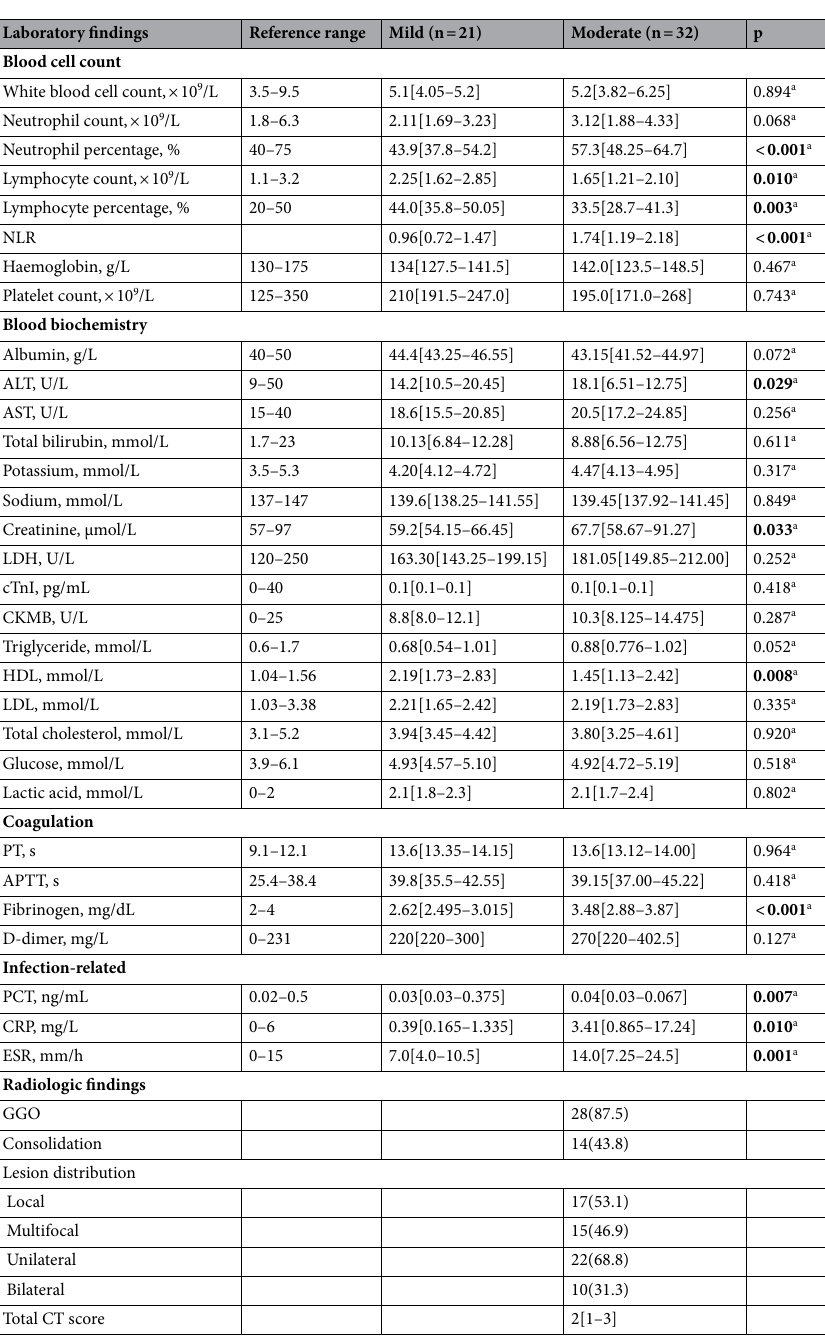
Table 2. Laboratory findings of patients with COVID-19. Laboratory findings are presented as the median (25% quantile-75% quantile); radiologic findings are presented as the number of cases (percentage). NLR neutrophil-to-lymphocyte ratio; ALT alanine aminotransferase; AST aspartate aminotransferase; LDH lactate dehydrogenase; cTnI cardiac troponin I; CKMB MB isoenzyme of creatine kinase; HDL high density lipoprotein; LDL low density lipoprotein; PT prothrombin time; APTT activated partial thromboplastin time; PCT procalcitonin; CRP C-reactive protein; ESR erythrocyte sedimentation rate; GGO ground glass opacity. a p according to the Wilcoxon rank sum test. All bold values indicate significant differences at the level of 0.05 for a highlight